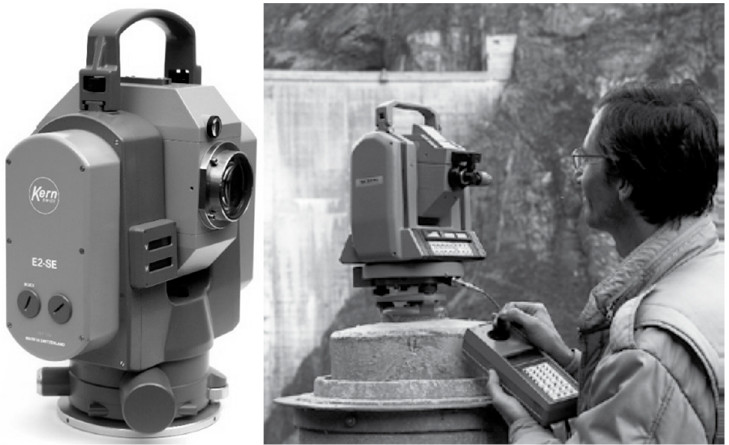
Figure 6. Video theodolites Kern E2-SE ( left ) [29] and Wild TM3000V ( right ) [30]. Shortly after Kern, the Wild company introduced its video theodolite model